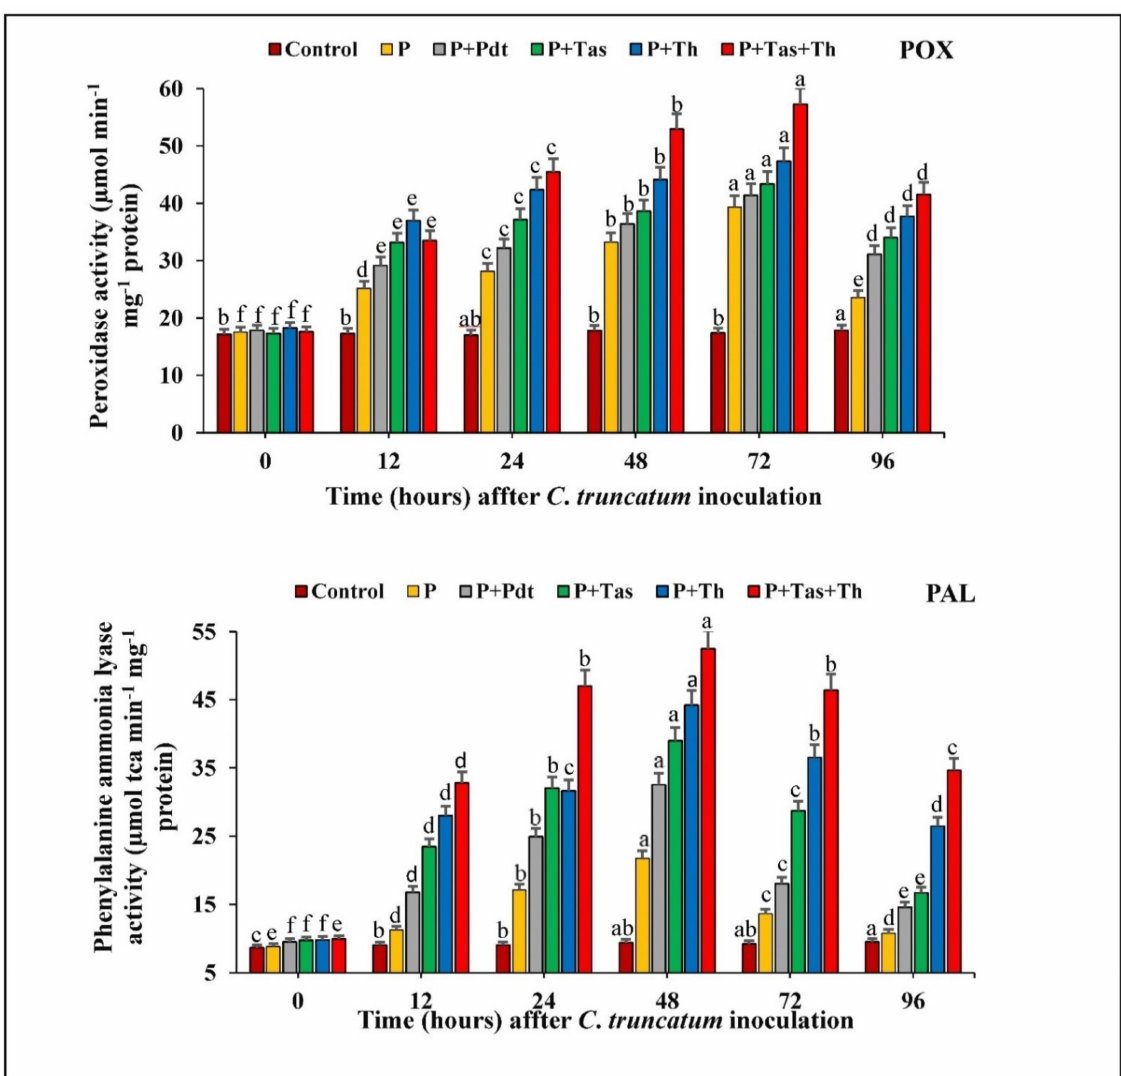
Figure 10. The effect of bioagents (Pdt = P. dendritiformis, Tas = T. asperellum, Th = T. harzianum, and Tas+Th = T. asperellum + T. harzianum ) on the accumulation of the defence enzymes (POX and PAL) either individually or in the combination of treatment in chilli seeds under a challenged condition and C. truncatum -infected samples. Each value is expressed as the mean of triplicates, and the bars sharing the same alphabetical letters are not significantly different ( p ≤ 0.05) using Duncan’s multiple range test. The vertical bar designates the standard